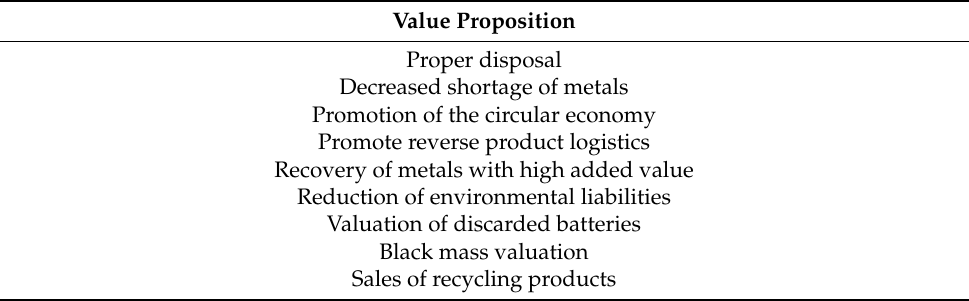
Table 13. Value proposition for LIB recycling business model.